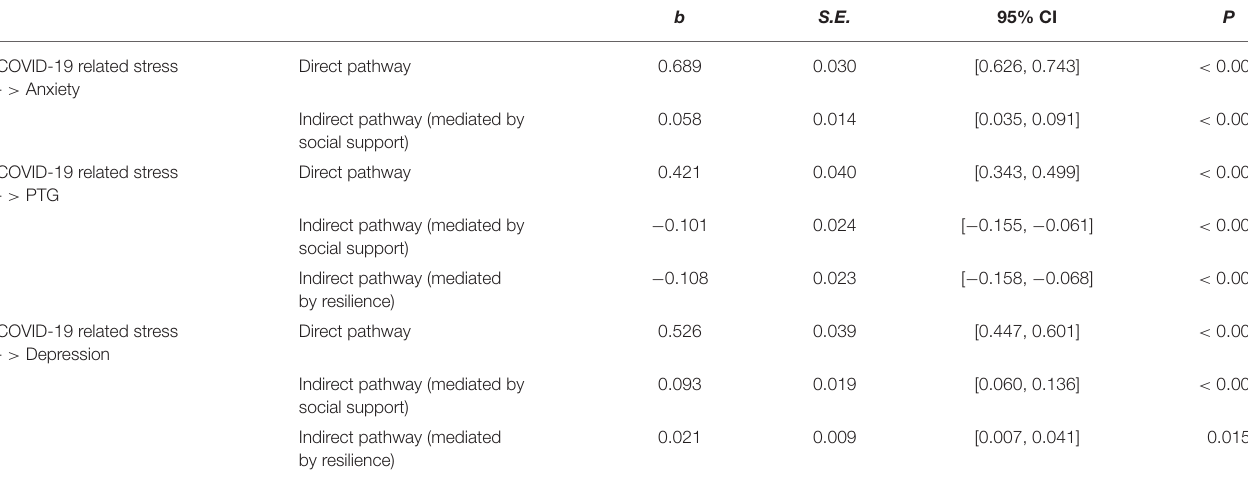
TABLE 3 | Direct pathway and indirect pathway coefficients of the final